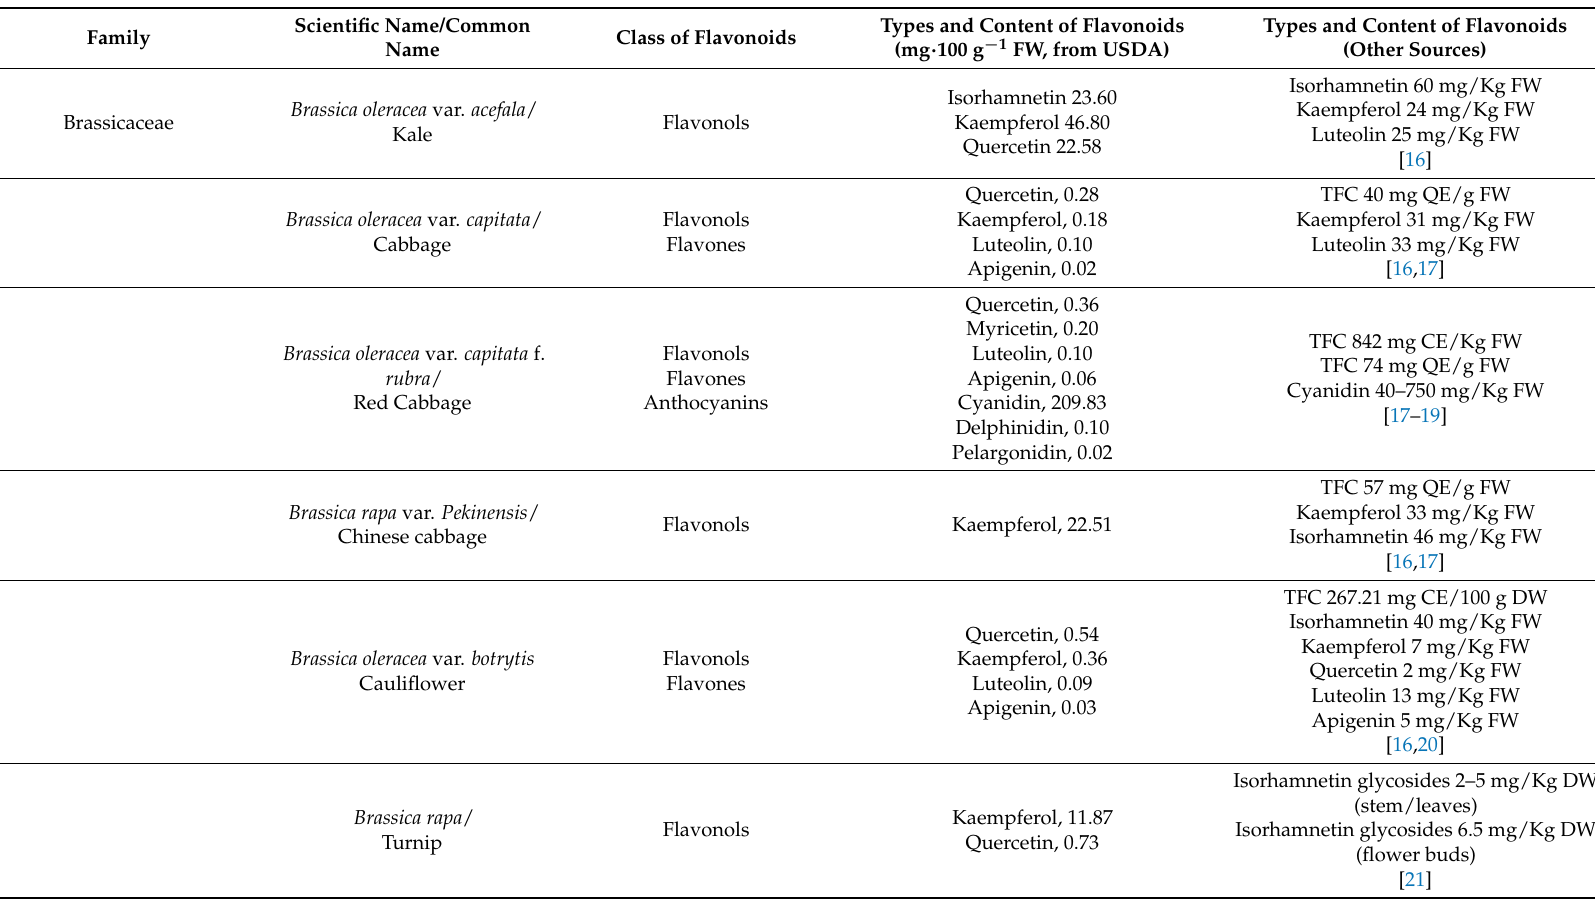
Table 1. Flavonoid classes and content in horticultural crops. Types and amounts of flavonoid are reported either from the USDA database (USDA; https://www.ars.usda.gov/) [15] or from literature. USDA source refers specifically to flavonoid content evaluated by column chromatography or HPLC analyses and are expressed as mg/100 g FW of edible portion. The literature source refers to either HPLC or spectrophotometric quantifications, with the aim to provide further information on flavonoid amounts and the total flavonoid content in horticultural crops. TFC: total flavonoid content. NA: not